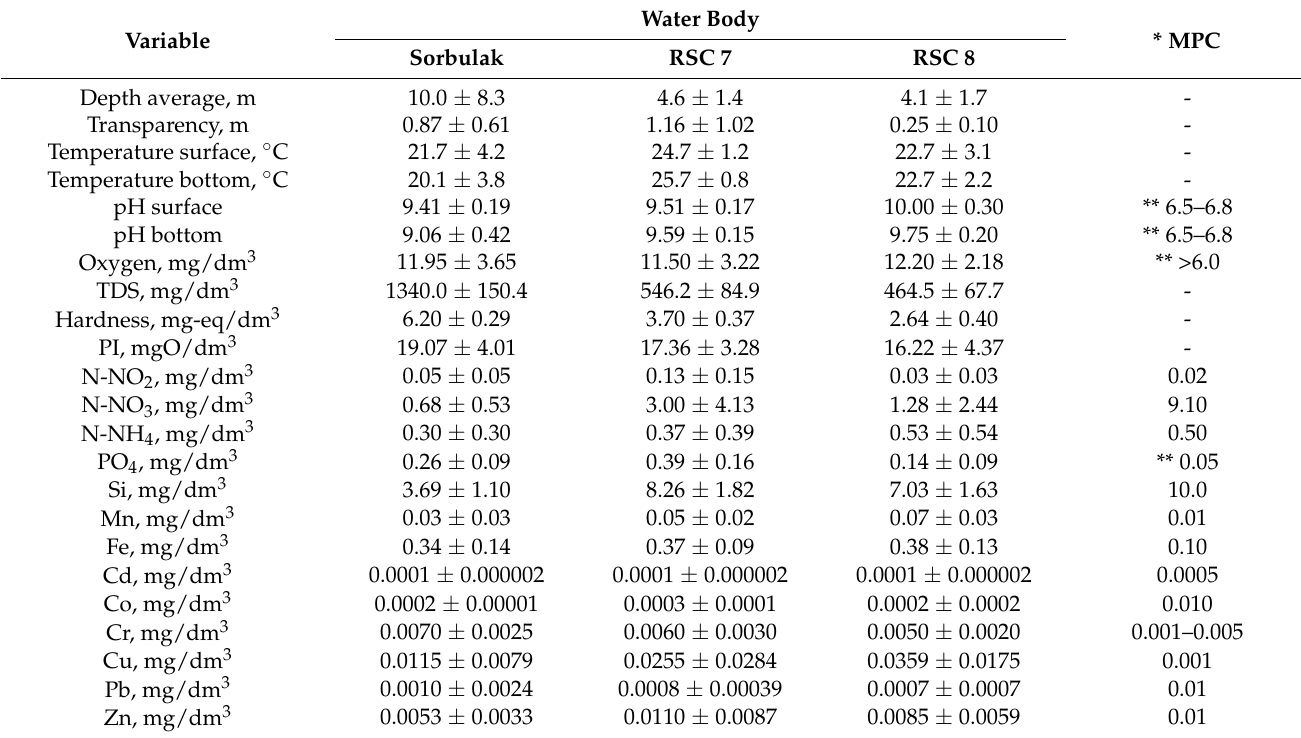
Table 1. Physical-chemical variables of wastewater reservoirs of the Right-Bank Sorbulak Canal system, 2021 (average values with standard deviation, n = 84 for each